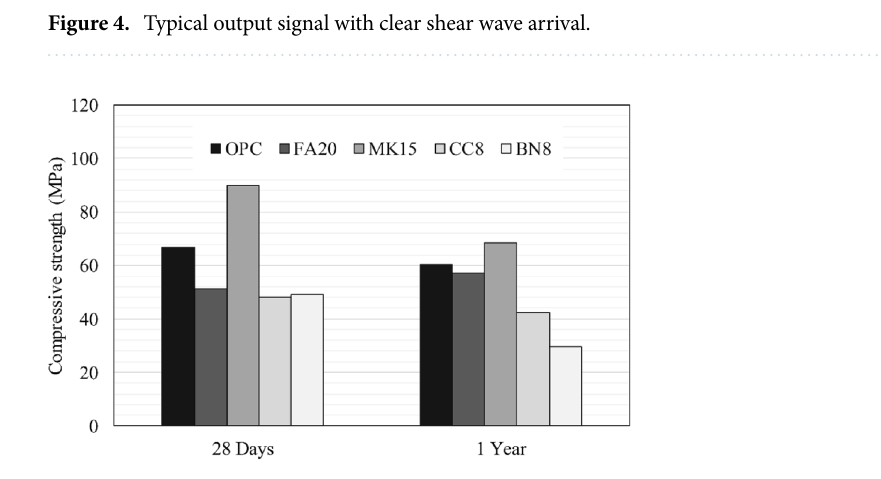
Figure 5. Compressive strength of pre-cracked mortar specimens subsequently submerged in